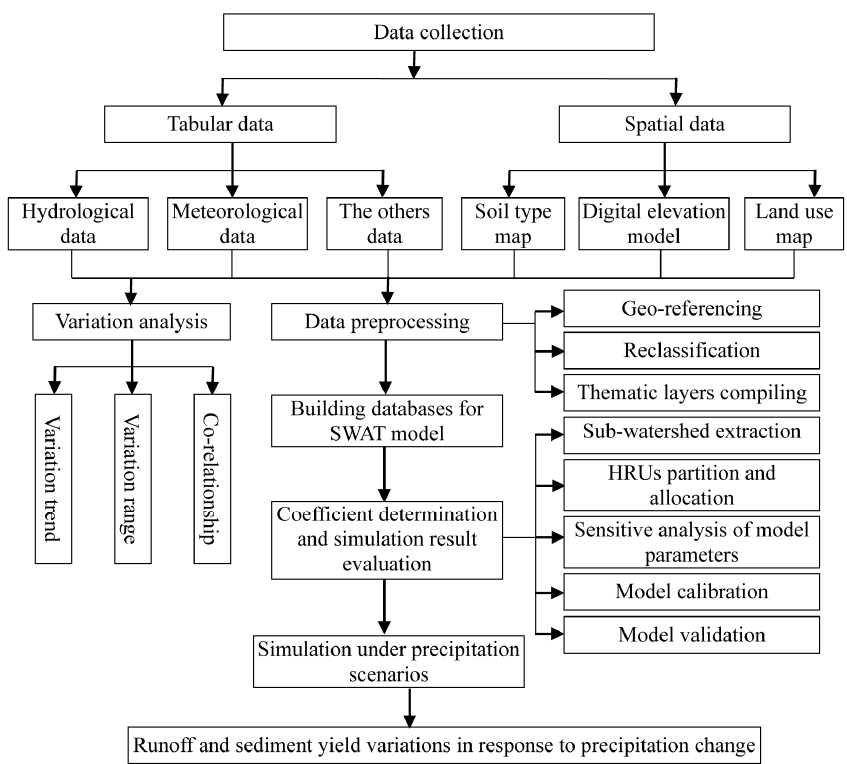
Figure 1. Technical workflow of this